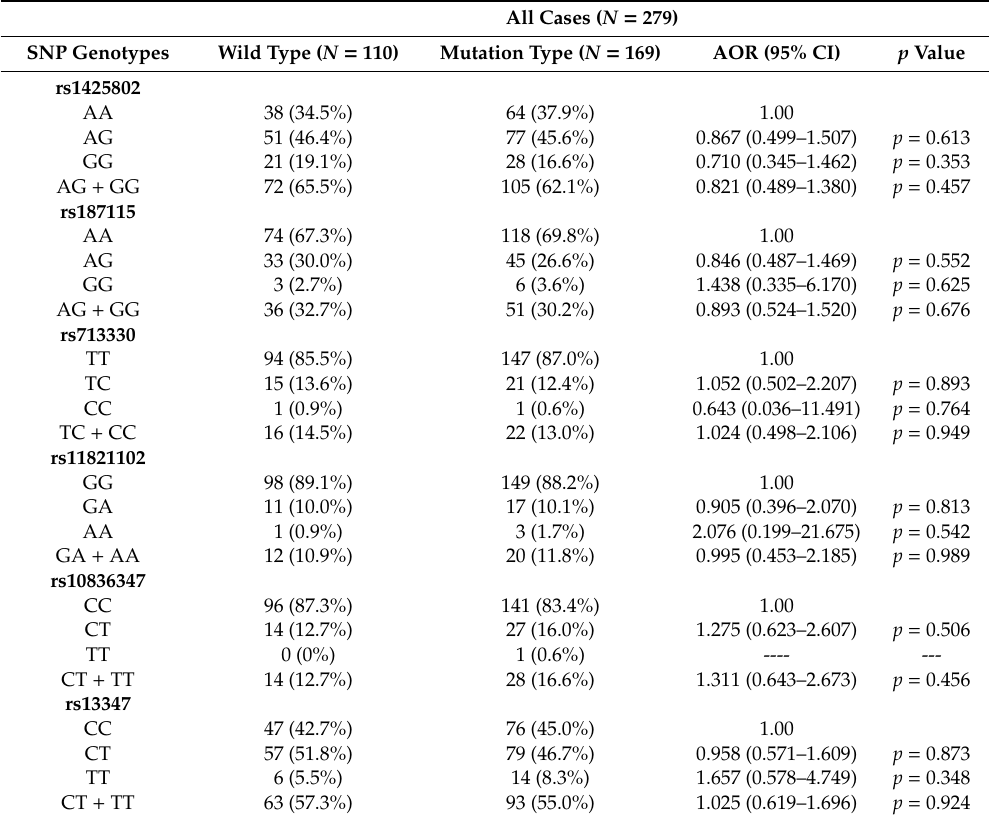
Table 2. Distribution frequency of CD44 genotypes of patients with lung adenocarcinoma and multiple logistic regression analysis of EGFR mutation association.